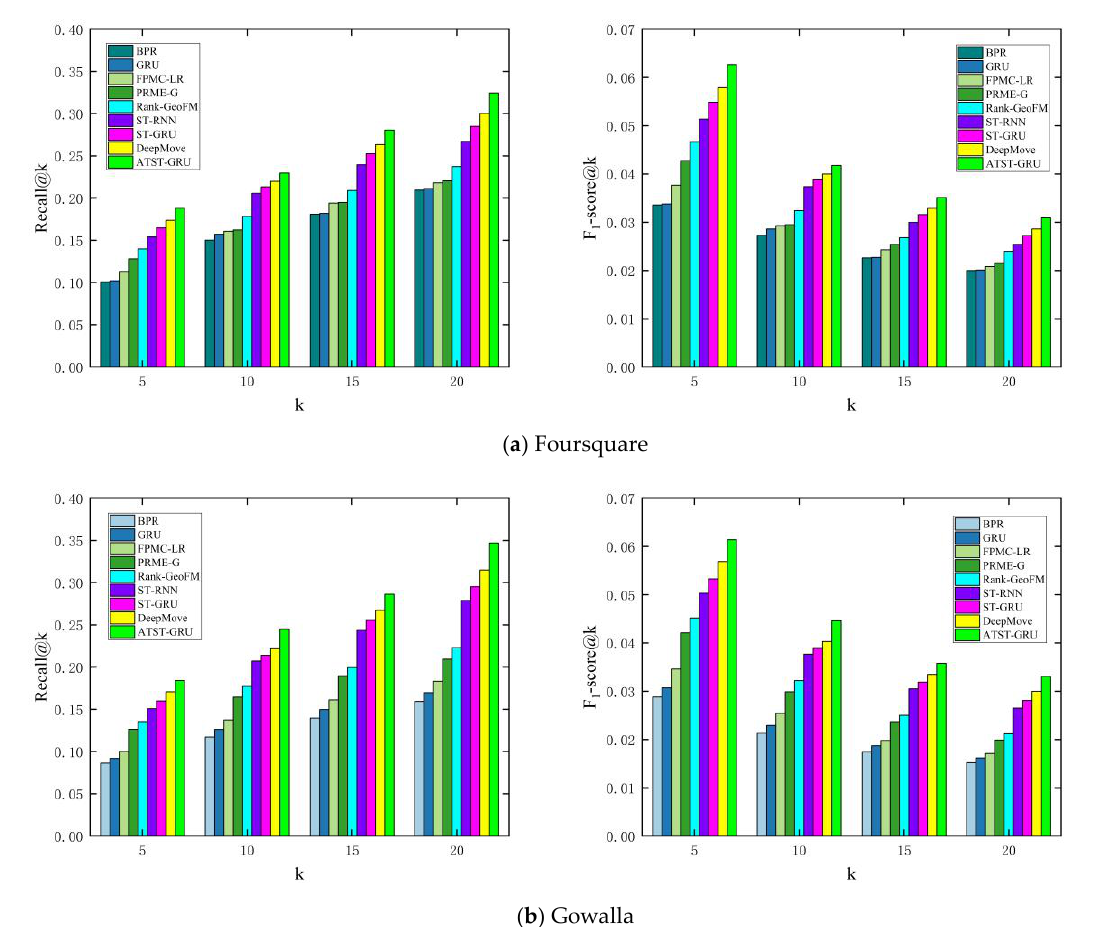
Figure 7. Recommendation performance comparison on Foursquare and Gowalla.